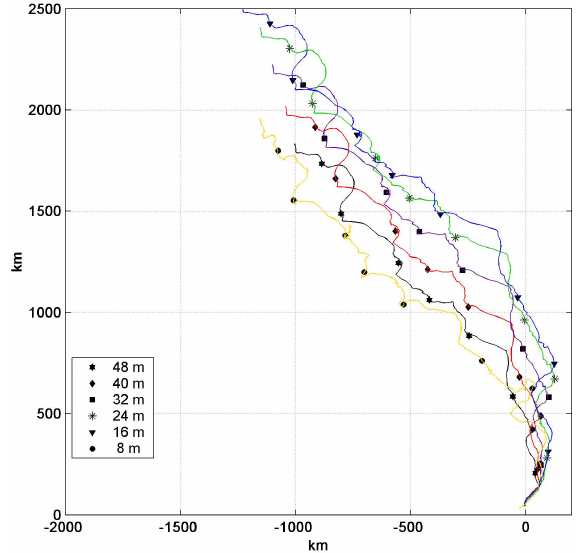
Fig. 8. Progressive Vector of daily mean data of horizontal currents from the ADCP at each level. Markers indicate the first day of each month. at the lowest depth; standard deviation spanned from 8.3